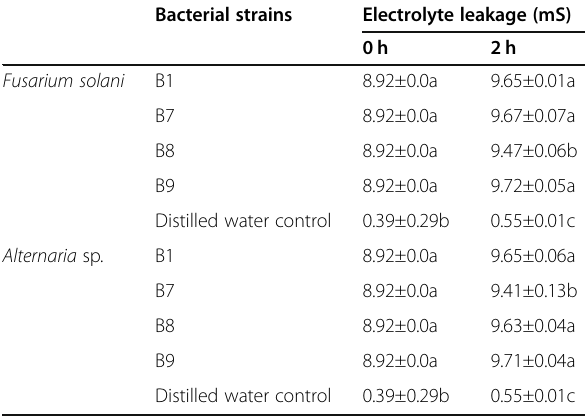
Table 3 Leakage of electrolytes from the mycelia of Fusarium solani and Alternaria sp. due to antifungal activity of cell-free culture supernatants of endophytic bacterial isolates Bacterial strains Electrolyte leakage